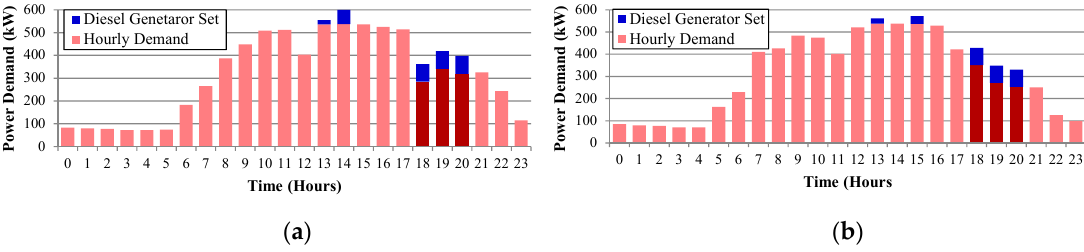
Figure 7. Scenario 3 daily maximum demand chart for ( a ) March and ( b ) November.